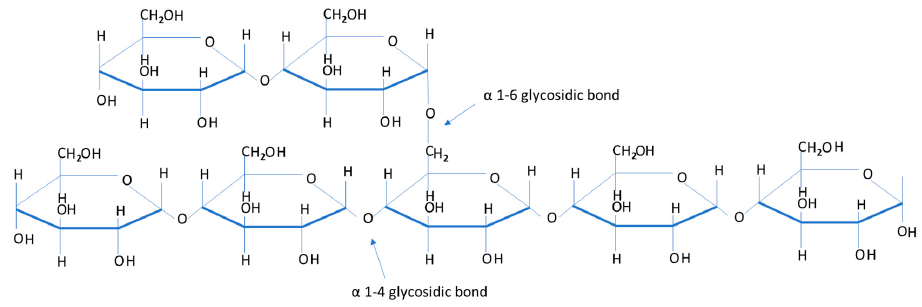
Figure 1. A section of a glycogen molecule illustrating individual glucosyl units. It shows the two different types of glycosidic bonds used to make up glycogen.